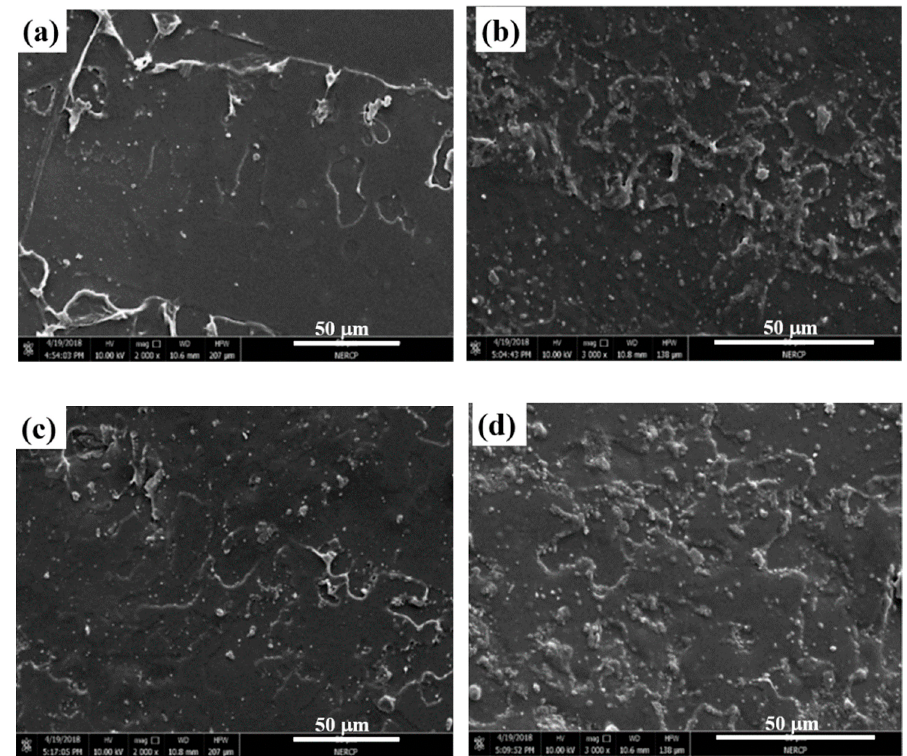
Figure 8. SEM micrographs of PLA and its biocomposites: ( a ) PLA, ( b ) PLA/Ac-lignin, ( c ) PLA/At-lignin, ( d ) PLA/By-lignin.